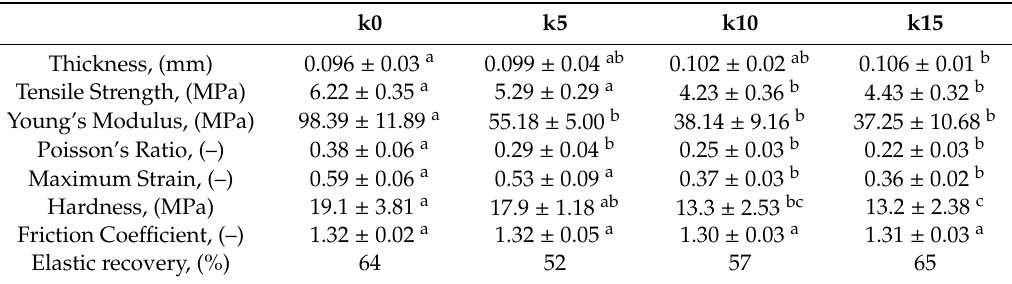
Table 1. The mechanical parameters of the